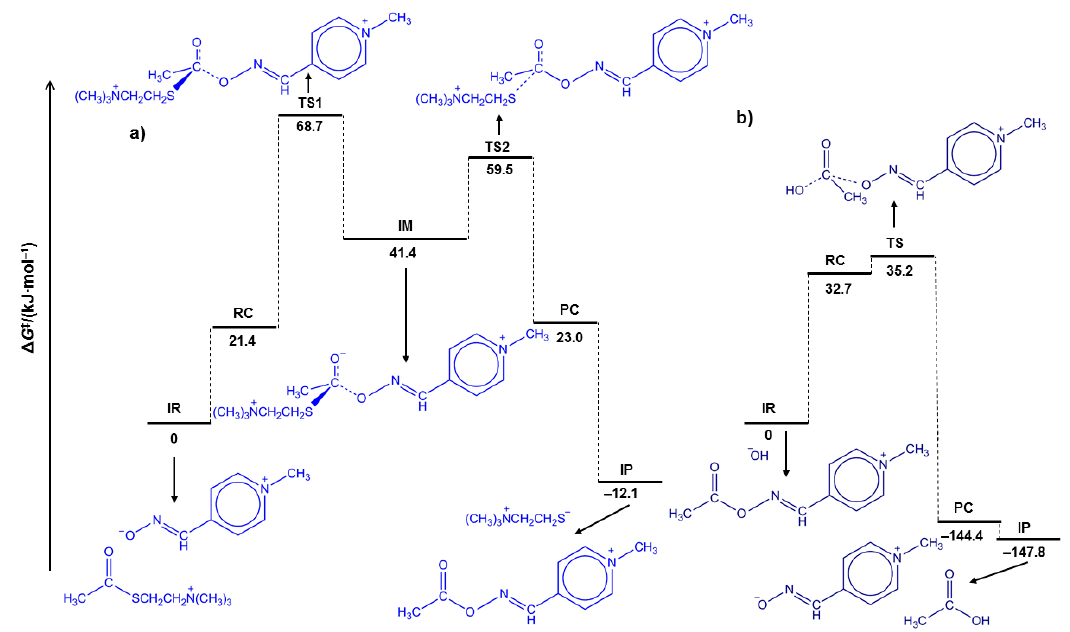
Figure 4. Free energy profiles for the ( a ) oximolysis of AcSCh + by PAM4 and ( b ) HO − -mediated